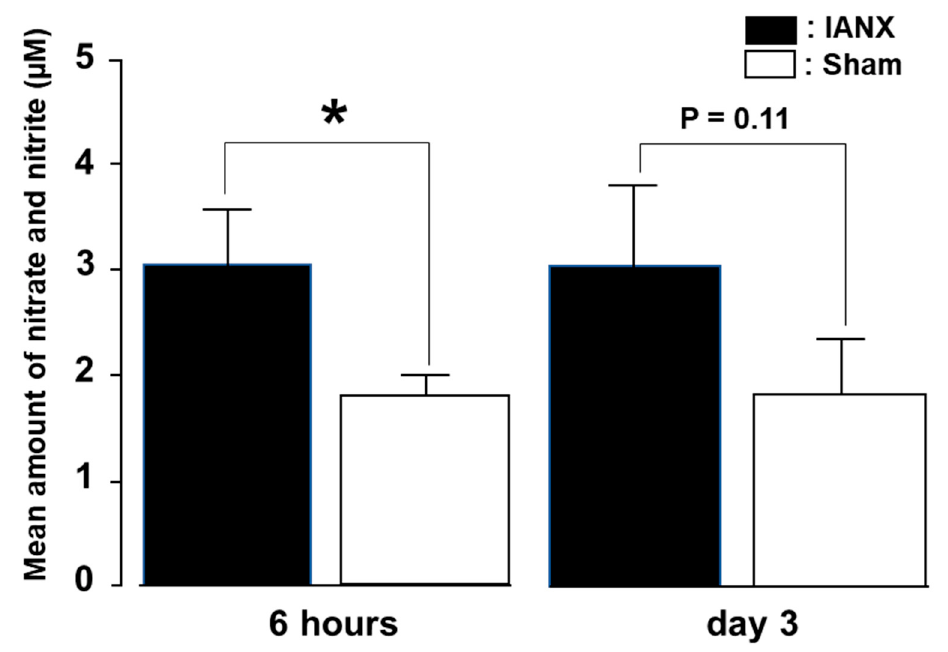
Figure 2. Nitrate and nitrite production in TG in sham and IANX rats. Quantitative analysis of nitrate and nitrite in TG at 6 h and on day 3 after IANX. *: p < 0.05. n = 4 in each group.